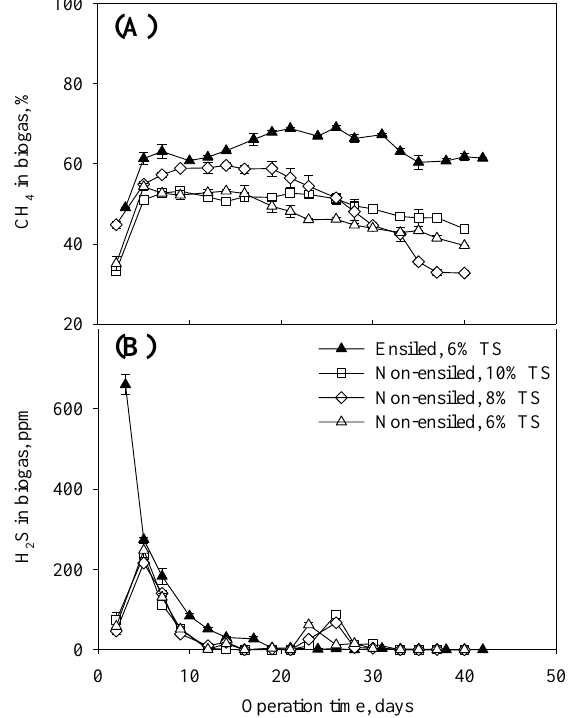
Figure 4. Methane ( A ) and hydrogen sulfide ( B ) concentrations in produced biogas.